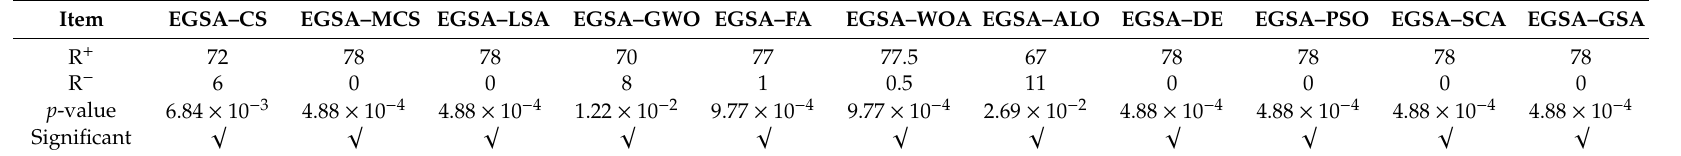
Table 4. The results of Wilcoxon signed-rank test for statistically significance level at alpha =